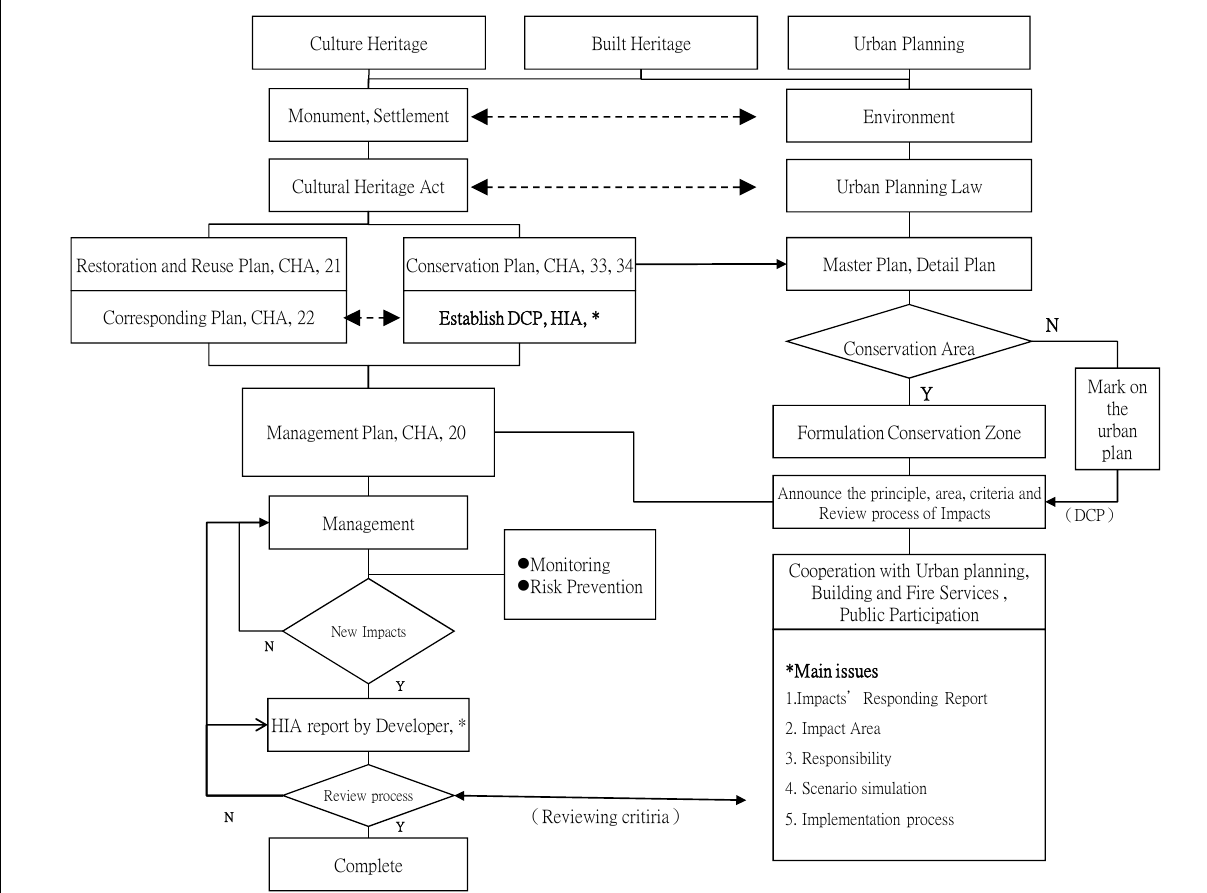
Figure 2. The integration frame of conservation plan in